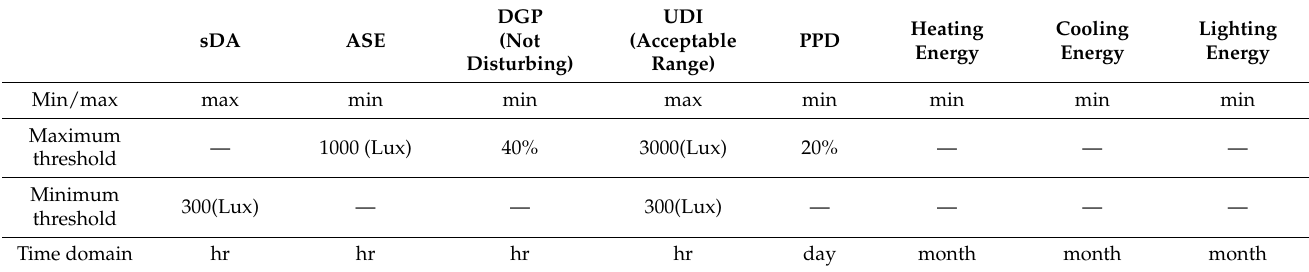
Table 4. The visual, thermal, and energy metrics to be